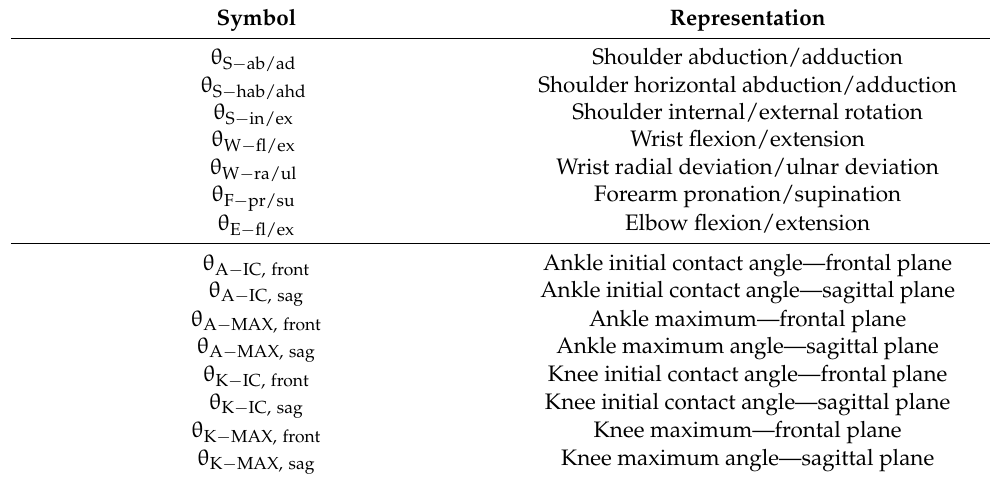
Table 1. Table showing the main angles on the joints of the upper and lower body limbs. Symbol Representation θ S − ab/ad Shoulder abduction/adduction θ S −